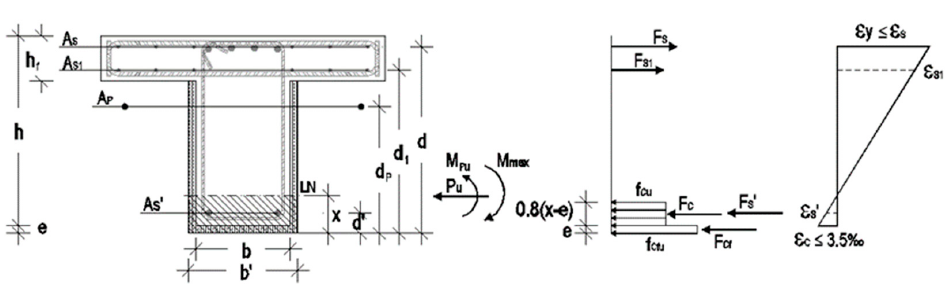
Figure 17. Section force equilibrium vs the peak moment.